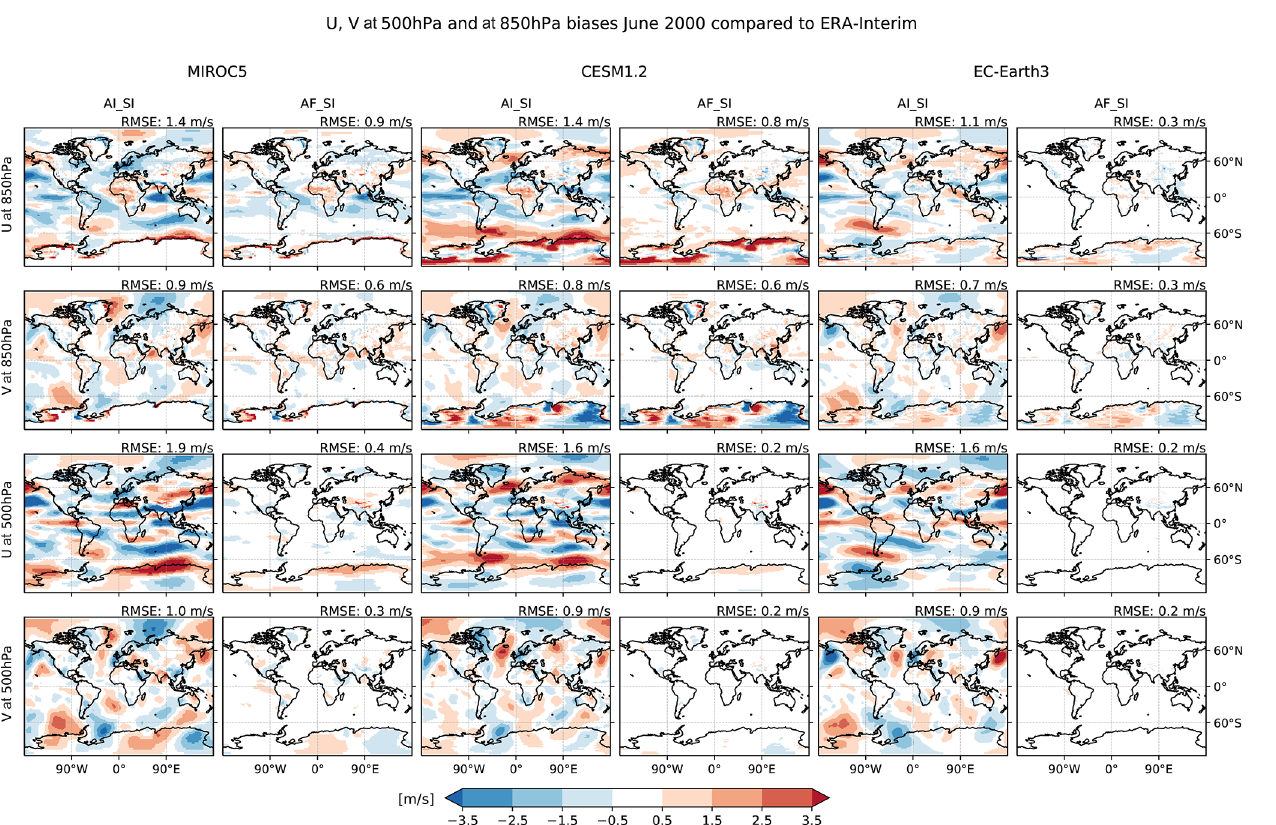
Figure A2. Bias of the zonal ( U ) and meridional ( V ) wind components at 850 and 500hPa for the experiments with a nudged atmosphere (AF_SI) and free atmosphere (AI_SI), showing the ensemble mean when multiple simulations are available. Shown is the average of 6-hourly wind fields for 1 month (June 2000). The winds from the models were interpolated to 500 and 850hPa. The winds from ERA-Interim were interpolated to the same pressure levels and the model resolution for each